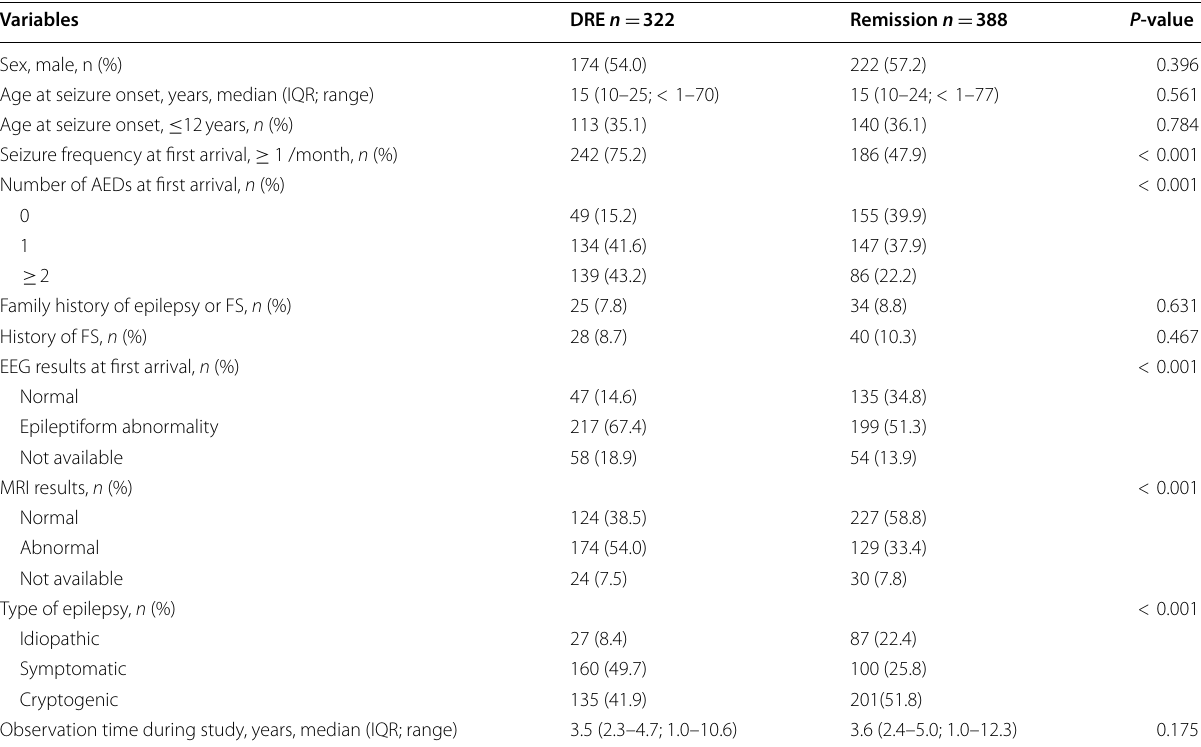
Table 4 Demographic and clinical predictors of drug-resistance in univariate